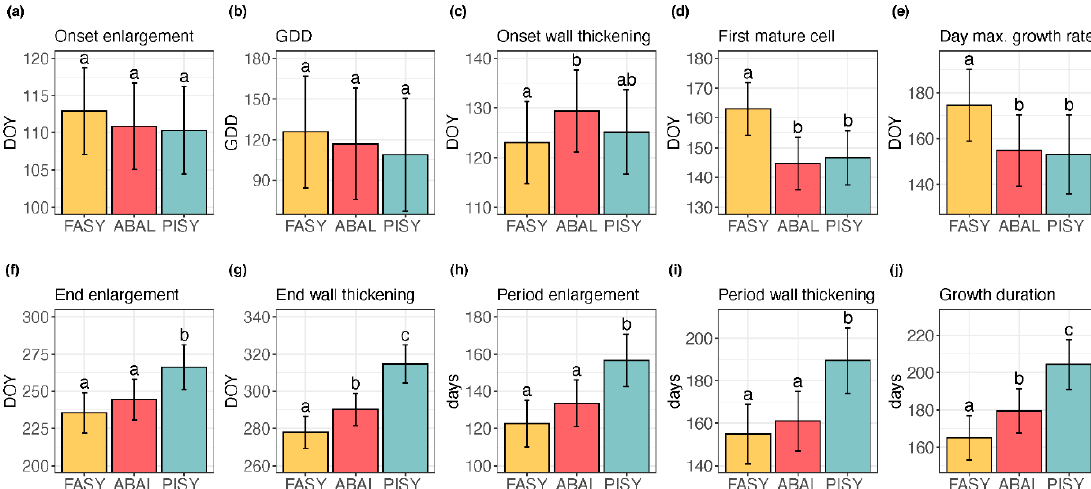
Figure 4. Estimated marginal means of the xylem phenology by species (onset enlargement ( a ), growing degree days ( b ), onset secondary cell wall thickening ( c ), onset maturation ( d ), the day of the maximum growth rate ( e ), cessation of enlargement ( f ), cessation of secondary wall thickening ( g ), the period of enlargement ( h ), the period of secondary wall thickening ( i ) and the overall growth duration ( j ); FASY: Fagus sylvatica , ABAL: Abies alba , PISY: Pinus sylvestris ). Error bars indicate 95% confidence levels of estimated marginal means. Different lowercase letters indicate significant differences of the sample means between the tree species ( p < 0.05).